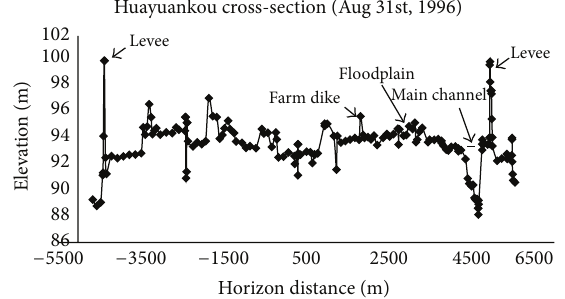
Figure 4: Typical cross-sectional profile at Huayuankou Station.